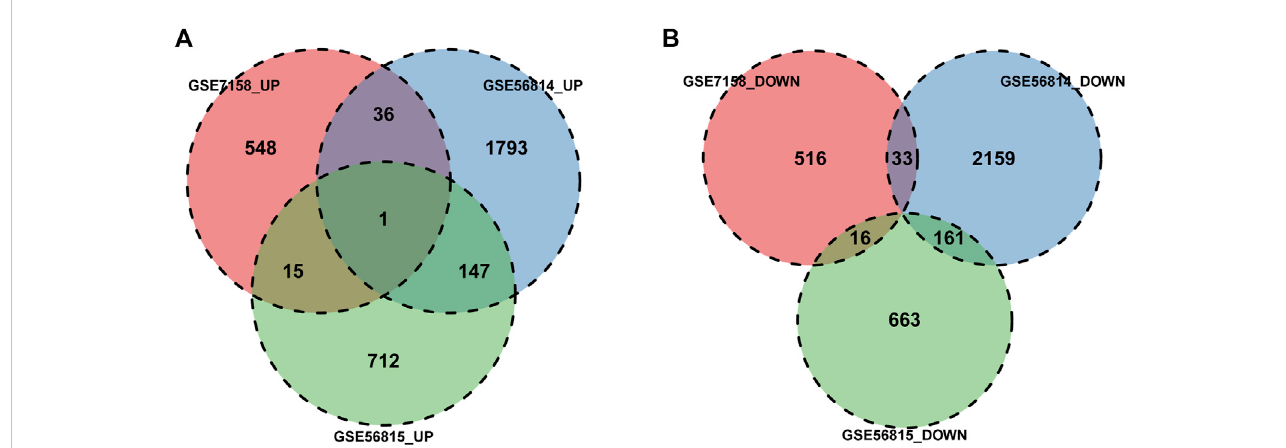
Enrichment analysis of DEGs. (A) Enrichment of DEGs using Gene Ontology (GO) analysis, including terms in biological process (BP) and cellular component(CC). (B) KyotoEncyclopediaofGenesandGenomes(KEGG)(right)analysis.Thelargerthecircleinthe fi gure,themoregenesitcontains;lower p values are indicated with a stronger red